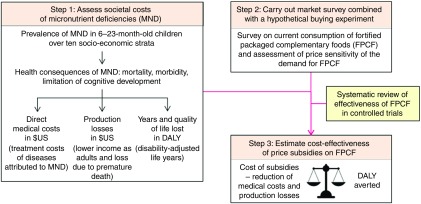
Overview of the model linking micronutrient deficiencies to health economic outcomes